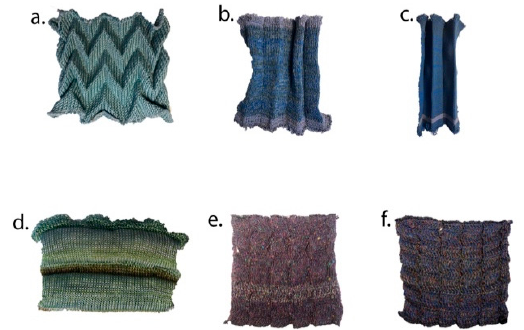
Figure 1. Study on pleats and stiffness: ( a ) Knitted sample, pleated with steam; ( b ) Knitted pleated sample, no stiffness; ( c ) knitted pleated sample, medium stiffness; ( d ) knitted sample, pressure sensor with conductive wool inside; ( e ) knitted pleated sample, good stiffness; ( f ) knitted pleated sample, good stiffness.